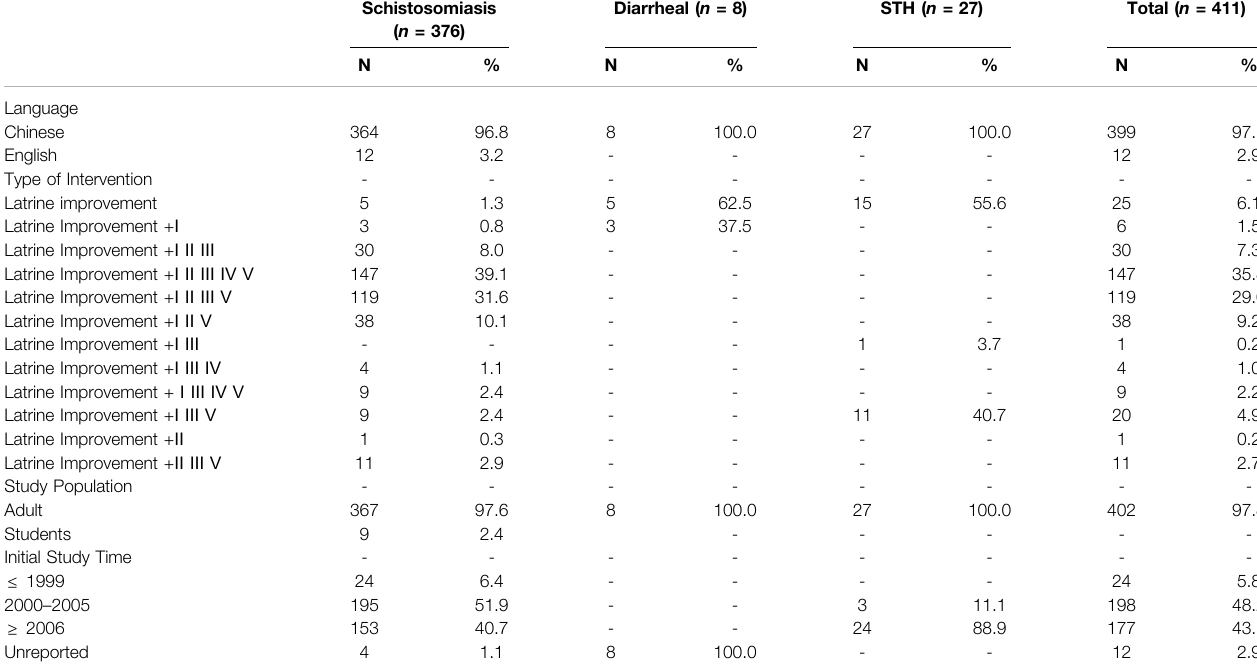
TABLE 2 | Overview of eligible records with extractable data.